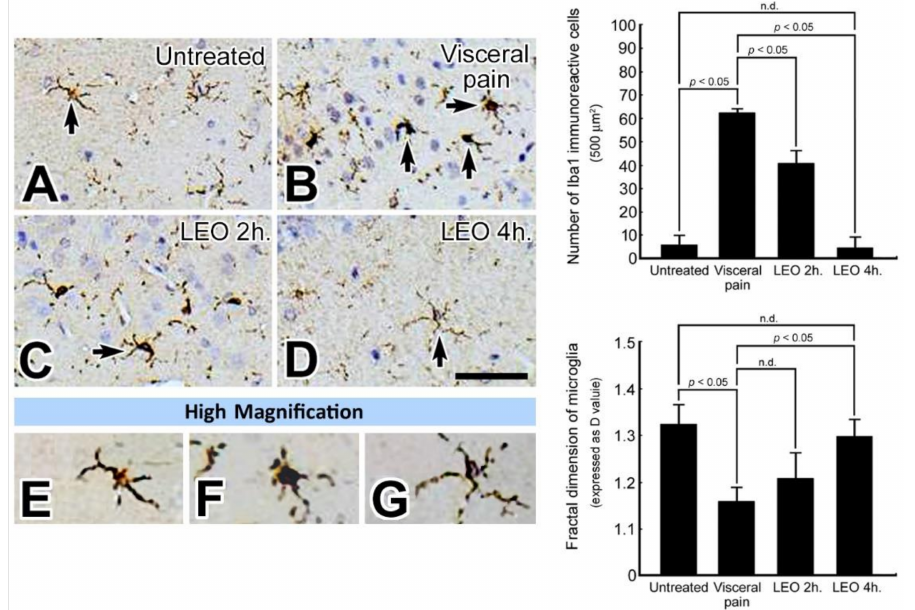
Figure 6. Photomicrographs ( A – G ) and histogram show the expression pattern of microglia (as determined by Iba1 immunohistochemistry) in the CeA of the untreated ( A ), visceral pain ( B ), and OS groups who received LEO for 2 h ( C ) and 4 h ( D ). Note that in the untreated group, only a small number of Iba1 immuno-reactive microglia with several branches and small cell bodies was detected in the CeA (arrow, A ). However, following visceral pain, a large number of microglia with retracted branching and large cell bodies was detected in the CeA (arrows, B ). Nevertheless, in rats subjected to visceral pain and who received LEO for 4 h, the expression pattern of microglia was much similar to that of untreated ones (arrow, D ). High magnification ( E – G ) clearly demonstrates the functional status of the microglia in which a resting state was found in untreated ( E ) and OS group ( G ) while an activated state was detected in the group that suffered from visceral pain ( F ). Quantitative evaluation corresponded well with immunohistochemical findings in which OS successfully restored the branching pattern of microglia (as expressed by D value) following visceral pain. n.d. = no significant difference. Scale bar = 20 µ m in ( A – D ), and = 10 µ m in ( E – G